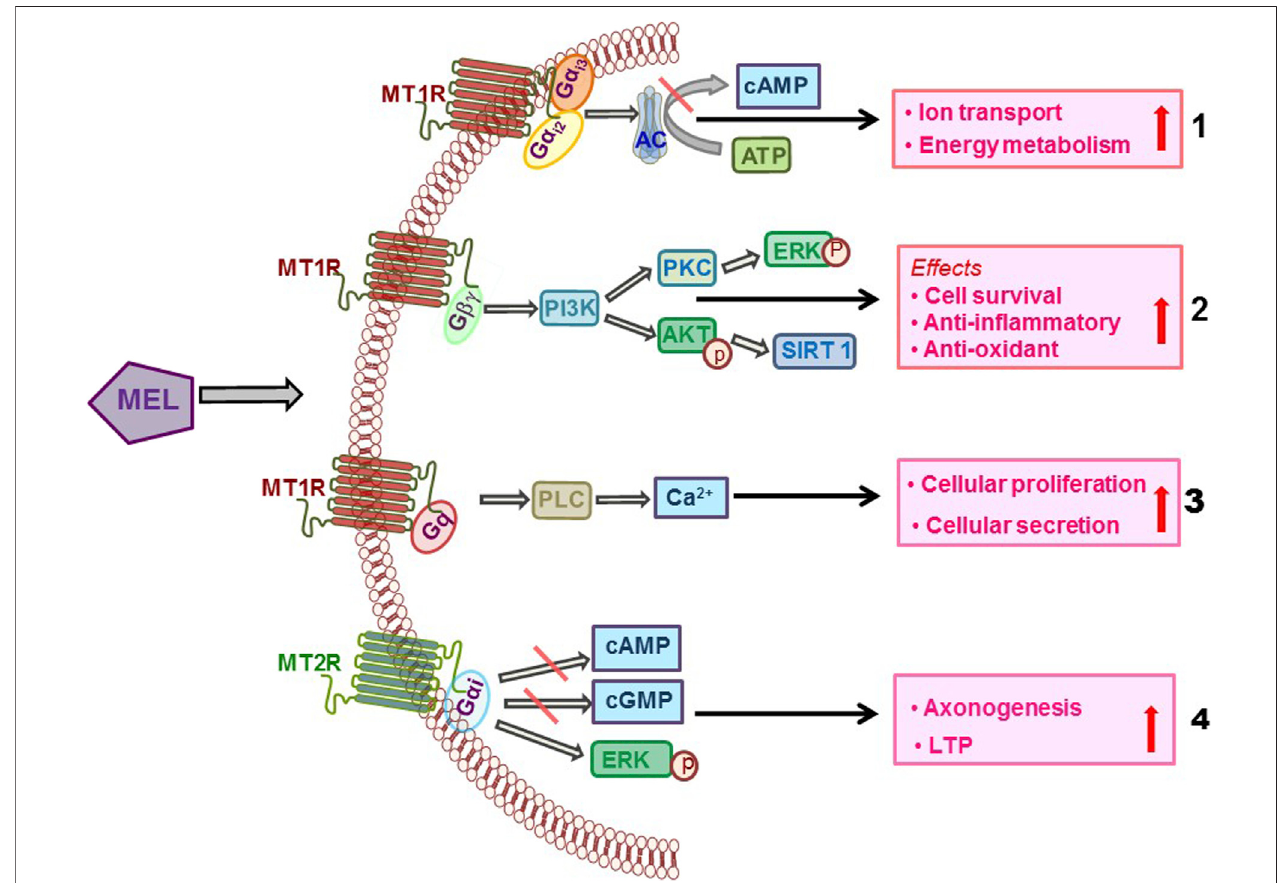
FIGURE 1 | Diverse coupling of Mel receptors with G proteins and consequent activation of the downstream cellular signaling that mediates the effects of Mel.